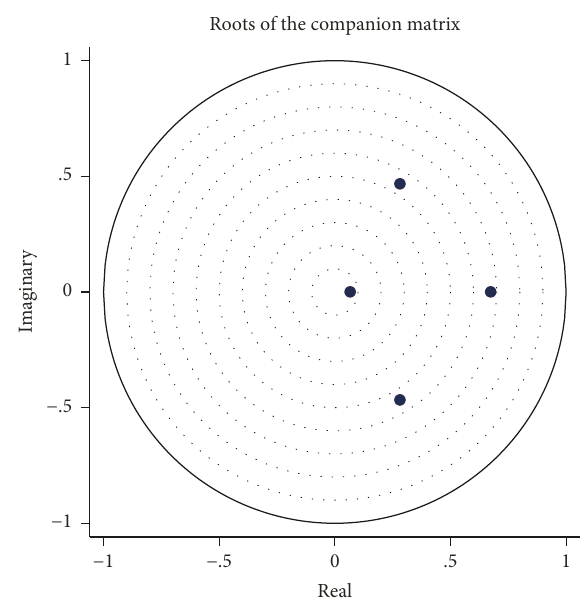
Figure 1: Roots of the companion